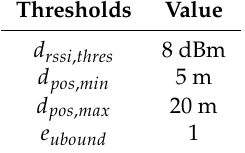
Table 1. The thresholds adopted for fingerprint-based constraints in our